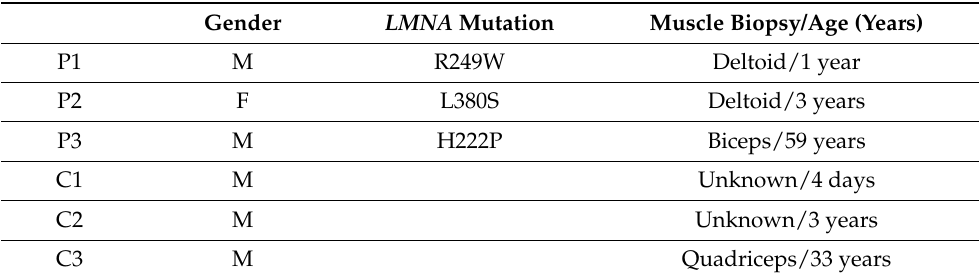
Table 2. Characteristic of